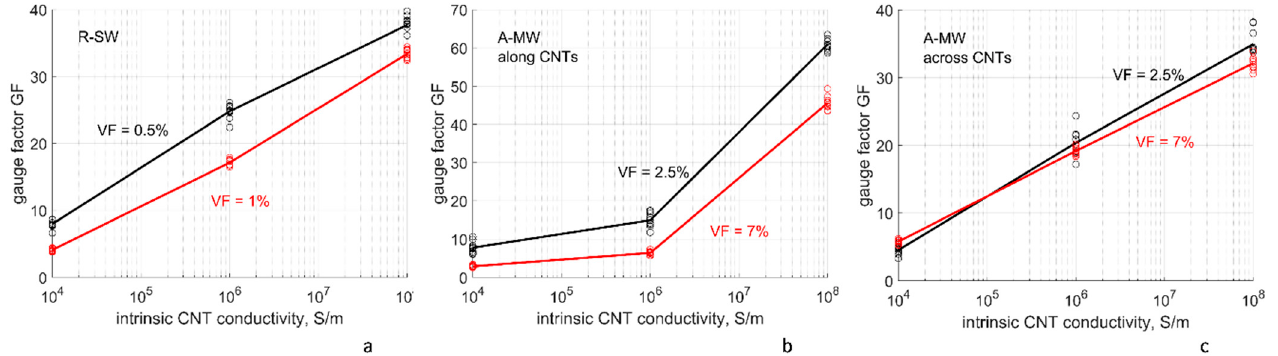
Figure 10. The gauge factors as a function of the assumed intrinsic conductivity of the CNTs, at two levels of the CNT volume fraction: ( a ) R-SW; ( b ) A-MW, along CNTs; ( c ) A-MW across CNTs. The points show conductivity values corresponding to different RVE random realizations; the lines show mean values; Δ E 1 = 3 eV; s min = 0.34 nm.